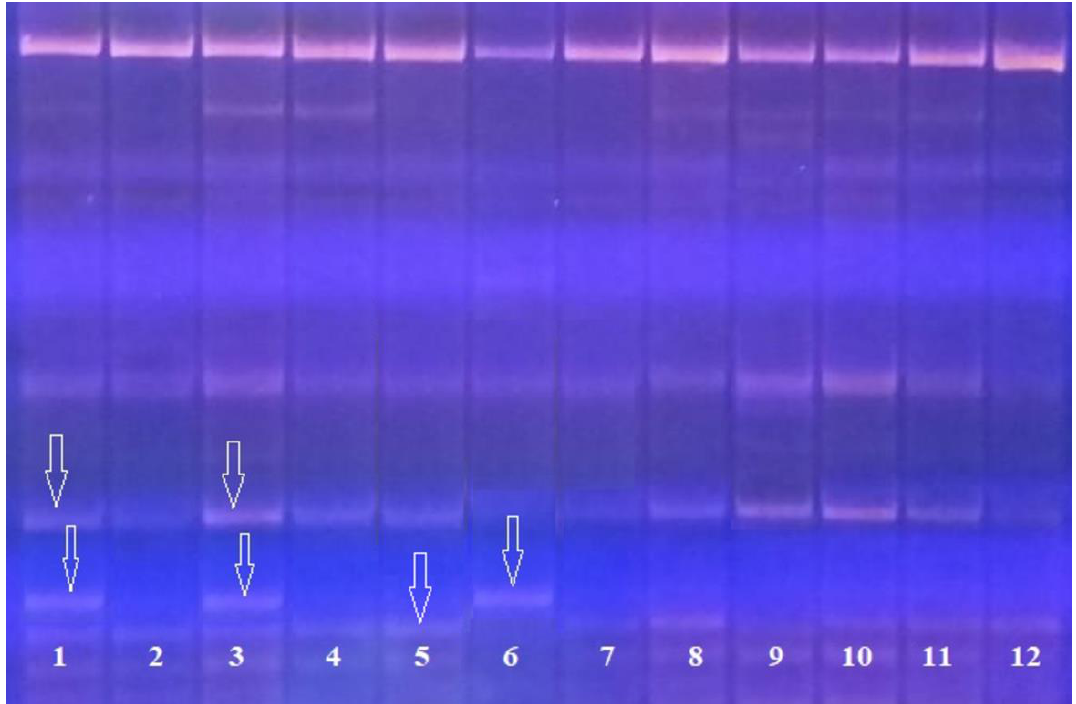
Figure 3. Electrophoregram of genomic DNA amplification products at the loci RM310 and RM72: 1–4, 7–12, analyzed hybrid BC 4 F 3 plants; 5, donor line of the Pi-33 gene C101-Lac; Flagman, maternal form.